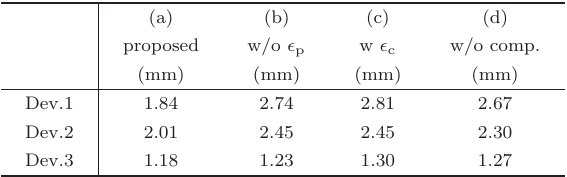
Table 4 Comparison of plane fitting errors in evaluation